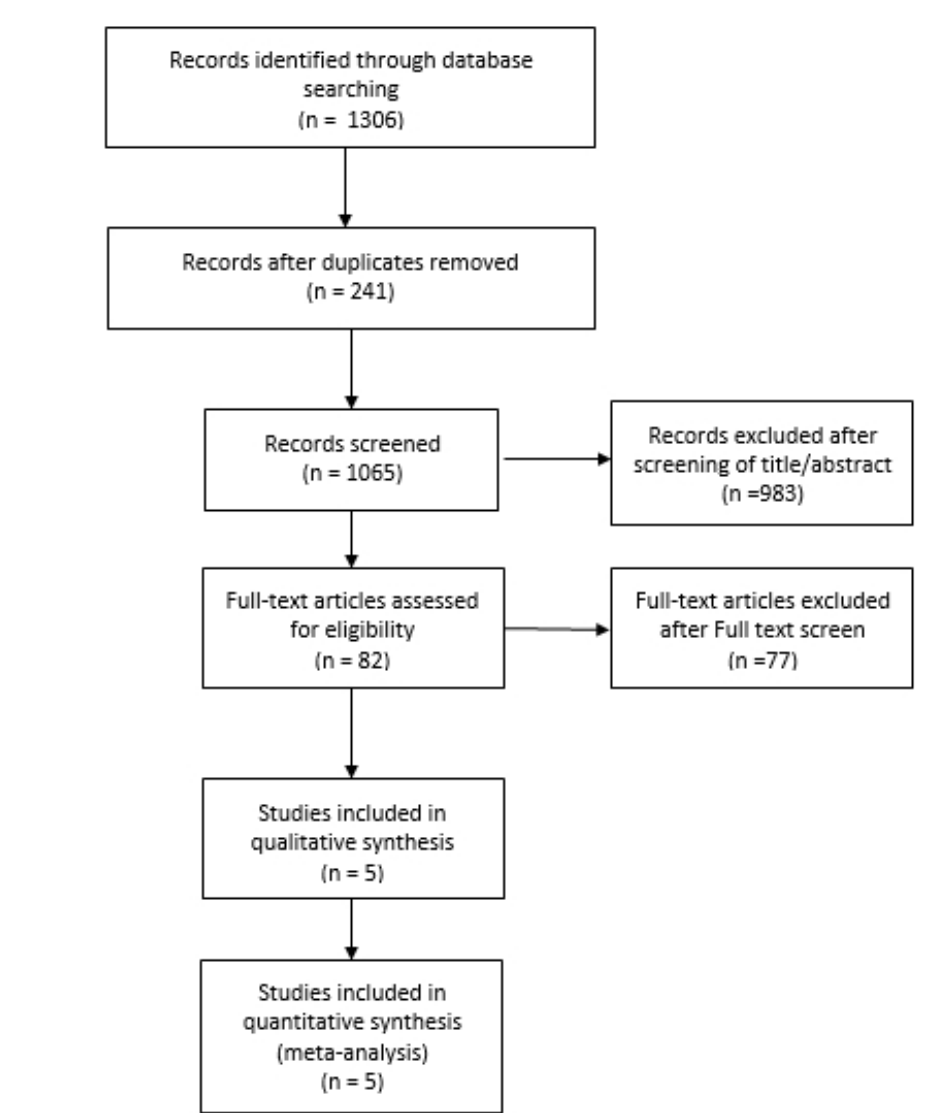
Figure 1. PRISMA fl ow diagram for systematic review. Figure 1. PRISMA flow diagram for systematic